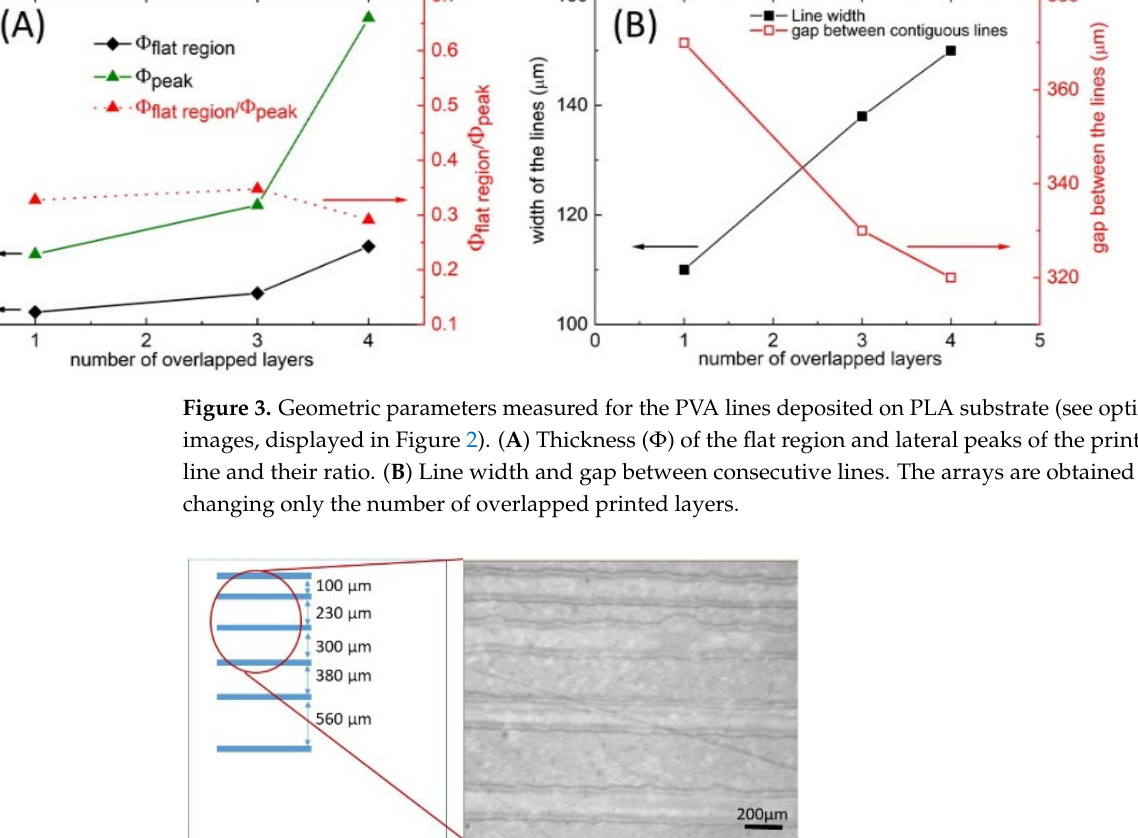
Figure 3. Geometric parameters measured for the PVA lines deposited on PLA substrate (see op- tical images, displayed in Figure 2). ( A ) Thickness (Φ) of the flat region and lateral peaks of the printed line and their ratio. ( B ) Line width and gap between consecutive lines. The arrays are ob- tained by changing only the number of overlapped printed layers.